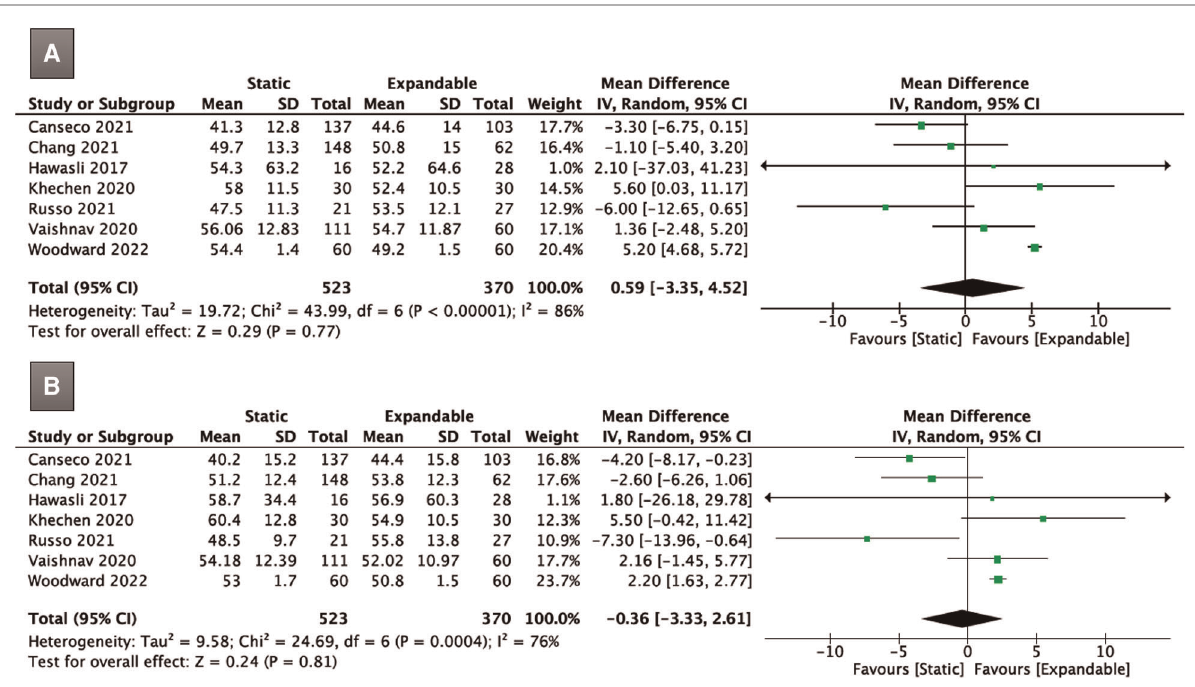
FIGURE 5 Forest plots for comparison of LL at preoperative ( A ) and fi nal follow-up ( B ) between the static and expandable groups. LL: lumbar lordosis.